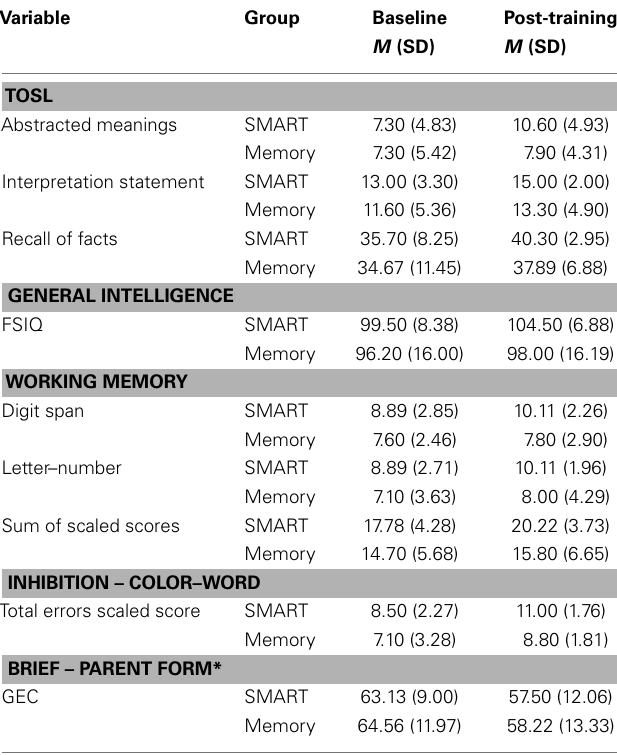
Table 3 | Baseline and post-training outcomes by group